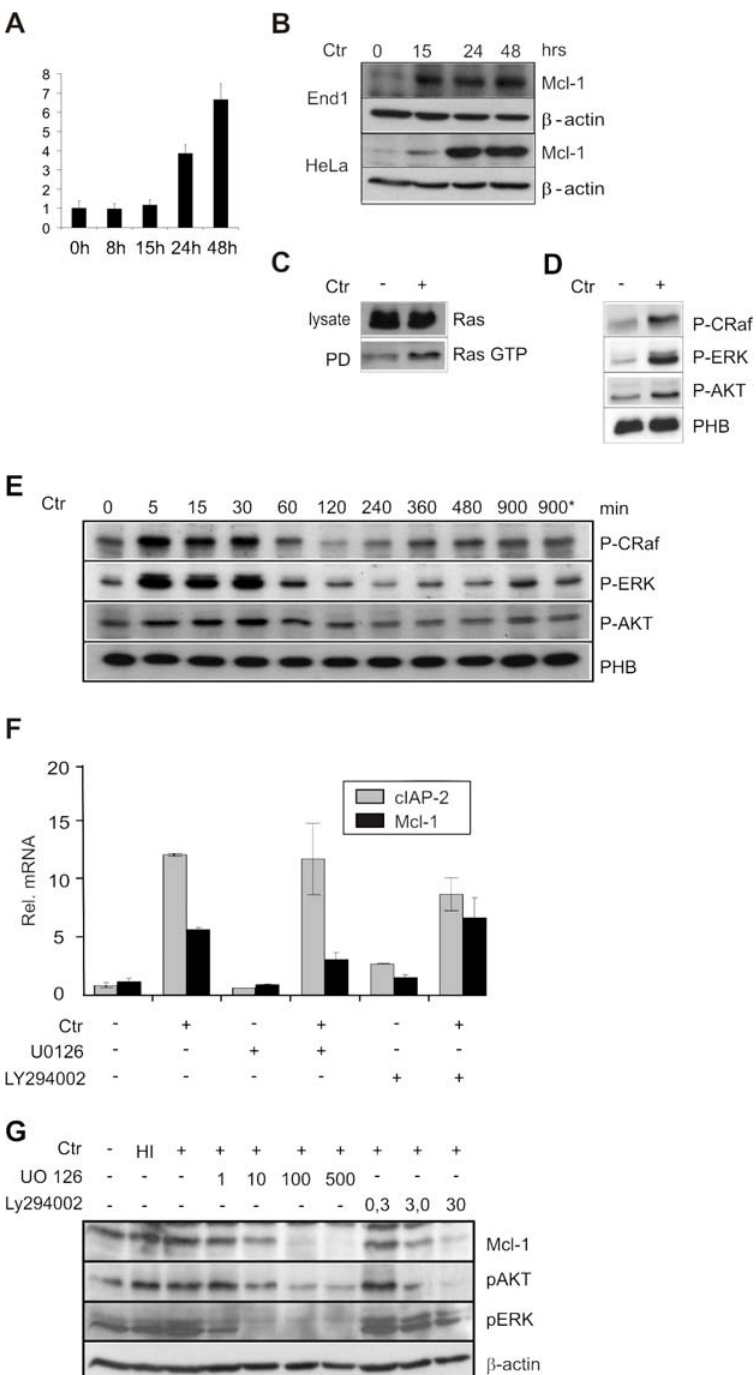
Figure 1. Mcl-1 is up-regulated via MAPK pathways during C.trachomatis infection. (A,B) HeLa cells were infected with C. trachomatis (MOI 3) and the expression of Mcl-1 was determined in HeLa cells by q-PCR (A) and in HeLa and End-1 cells by immunoblot analysis, at various time points post infection (B). (C) Infection with C. trachomatis leads to the activation of Ras in the host cells. Serum-starved HeLa cells were infected with C. trachomatis for 15 h and active Ras GTP was pulled down as mentioned in Materials and Methods S1. Total Ras in the lysates and in the pull down sample (PD) was monitored. ( D ) HeLa cells were infected with C. trachomatis (Ctr) at a MOI of 3 for 20 h and the activation of Raf, ERK and AKT was checked by immunoblot analysis using phospho-specific antibodies. Prohibitin (PHB) was used as loading control. (E) Early time points of the experiment described under (D). HeLa cells were infected for the indicated time points (minutes). One control with heat inactivated bacteria (900*) was included. (F) Up-regulation of Mcl-1 mRNA is dependent on MEK-1. Cells were infected either in the presence or absence of 10 m M of U0126 or 62.5 m M of LY294002 for 20 h. The cells were then lysed and the expression of Mcl-1 and cIAP-2 was monitored by q-PCR analysis. Shown are the data from three independent experiments. The error bars represent the 6 SD of the mean. (G) MEK-1 and PI3K involved in the regulation of Mcl-1 protein levels. Cells were infected with heat inactivated (HI) or living C. trachomatis and the MAPK inhibitors U0126 (1, 10, 100 and 500 m M) and LY294002 (0.3, 3 and 30 m M) were added. The cells were then lysed at 20 h post infection and the protein levels of Mcl-1 were monitored by immunoblot analysis. Actin was used as a loading control.